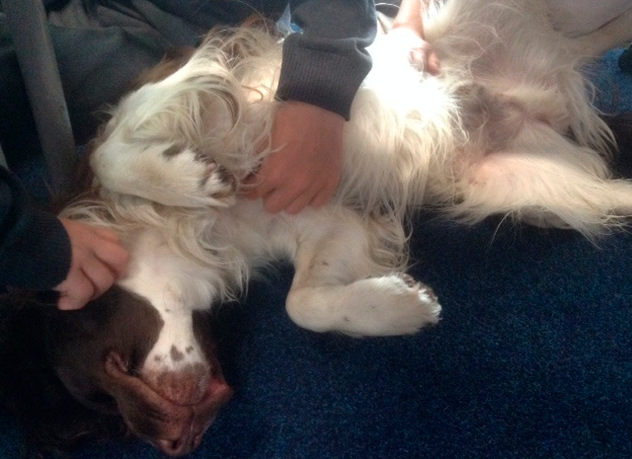
Figure 1. Ted’s “springer sprawl”—using his body language to “talk” and initiate tummy and chest rubs from the children.